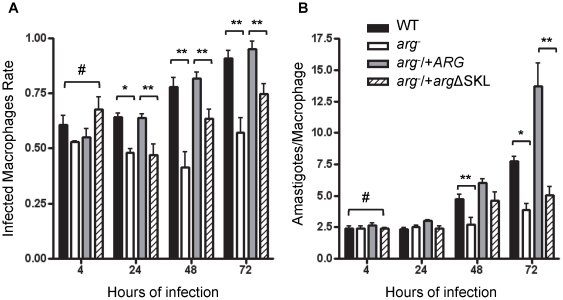
ARG absence or improper sub-cellular location impairs L. amazonensis in vitro infectivity.Peritoneal macrophages infected with L. amazonensis wild type (WT, white bars), ARG knockout (arg
−, black bars) and the add-backs arg
−/+ARG (grey bars) and arg
−/+argΔSKL (dashed bars) mutants for 48 and 72 hours. (A) Means (+/− SD) of the rate of macrophage infection from two experiments. (B) Means (+/− SD) of amastigotes per infected macrophage from two experiments. At least 150 macrophages were analyzed for each experiment. # indicates values with no significant difference (One-way ANOVA). * p<0.005 and ** p<0.05 (t test).